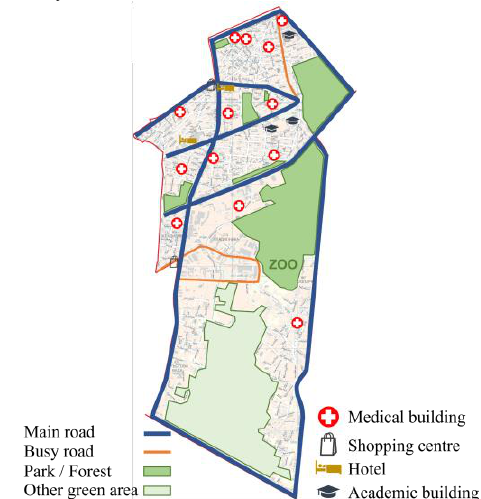
Figure 1 . Map of the district of Lozenets with main